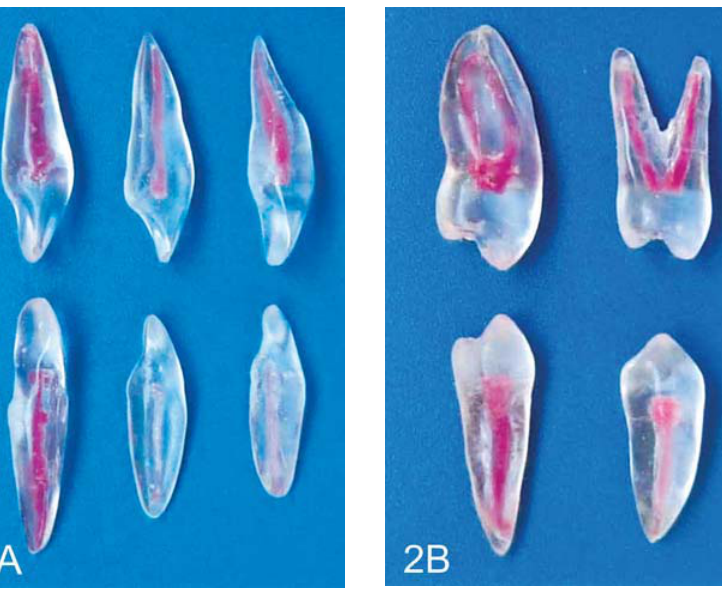
FIGURE 3A- Transparent resin molars FIGURE 2B- Transparent resin